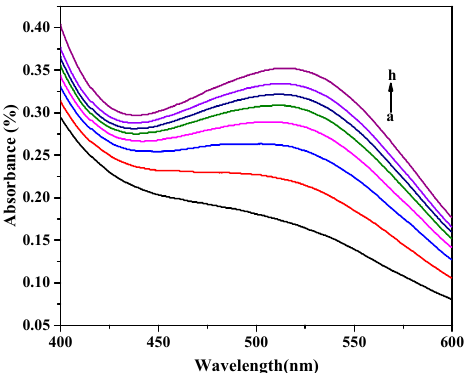
Figure 4. UV − VIS spectra of RAC catalyzed by SiW 9 Cu 3, with 80 µL SiW 9 Cu 3 , 100 µL RAC, and 160 µL H 2 O 2 . Reaction times (a) 5, (b) 10, (c) 15, (d) 20, (e) 25, (f) 30, (g) 35, and (h) 60 min.